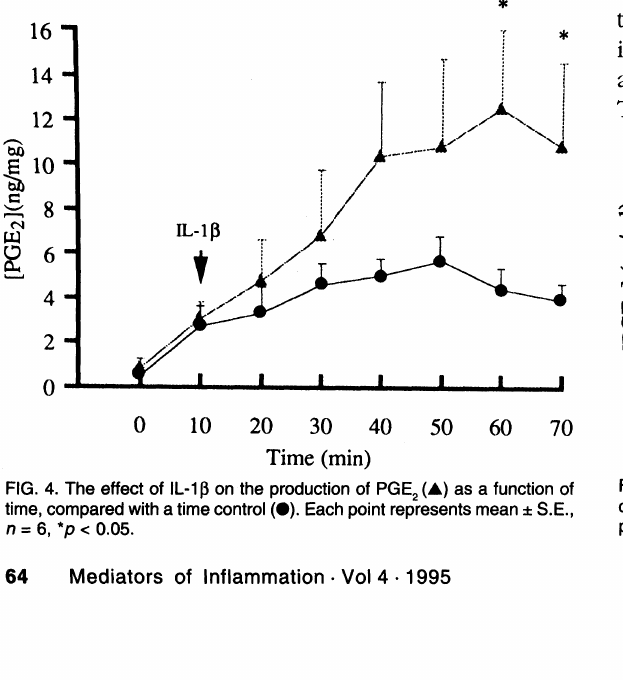
FIG. 6. Levels of IL-1 induced-production of PGE in the presence of cycloheximide (100 lg/ml) (A) compared with a time control (0). Each point represents mean +/- S.E., n